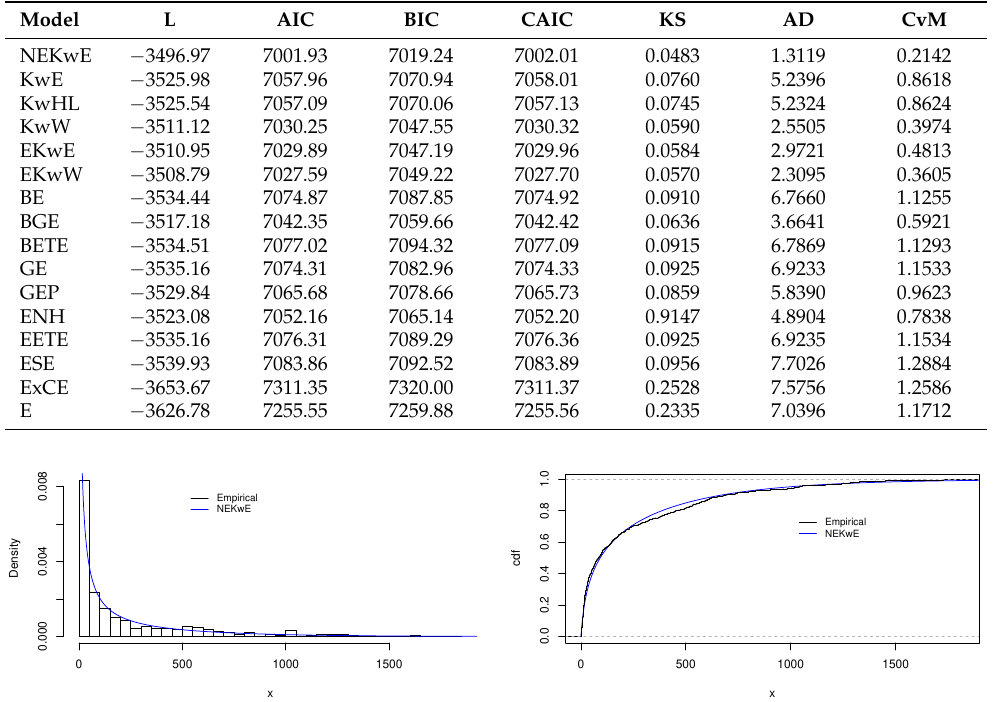
Table 9. Estimated log-likelihood value, model selection criteria, and goodness-of-fit measures of the considered models for the second data set.